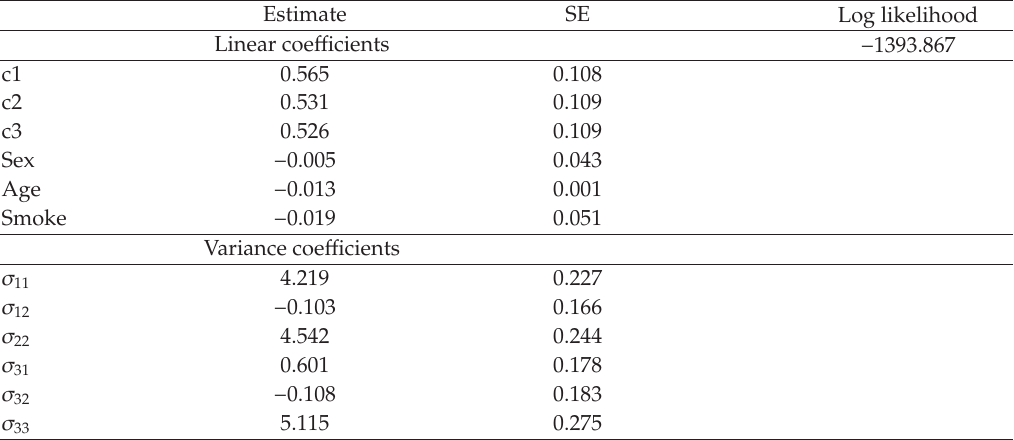
Table 5: Q1, Q2, and Q4 under a multivariate polygenic